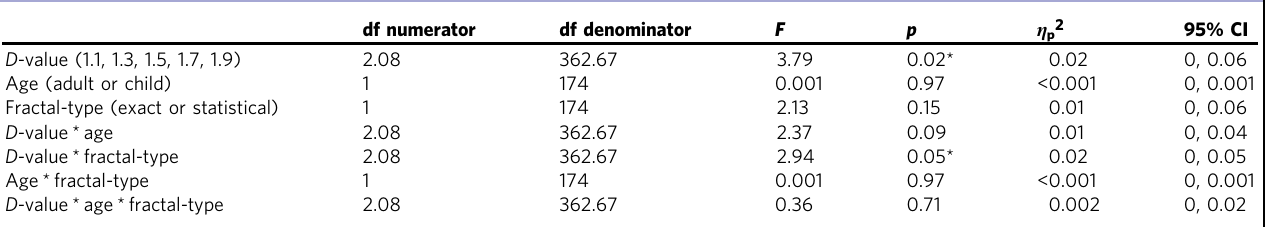
Table 1 Mixed ANOVA across D- value, age, and fractal type. df numerator df denominator